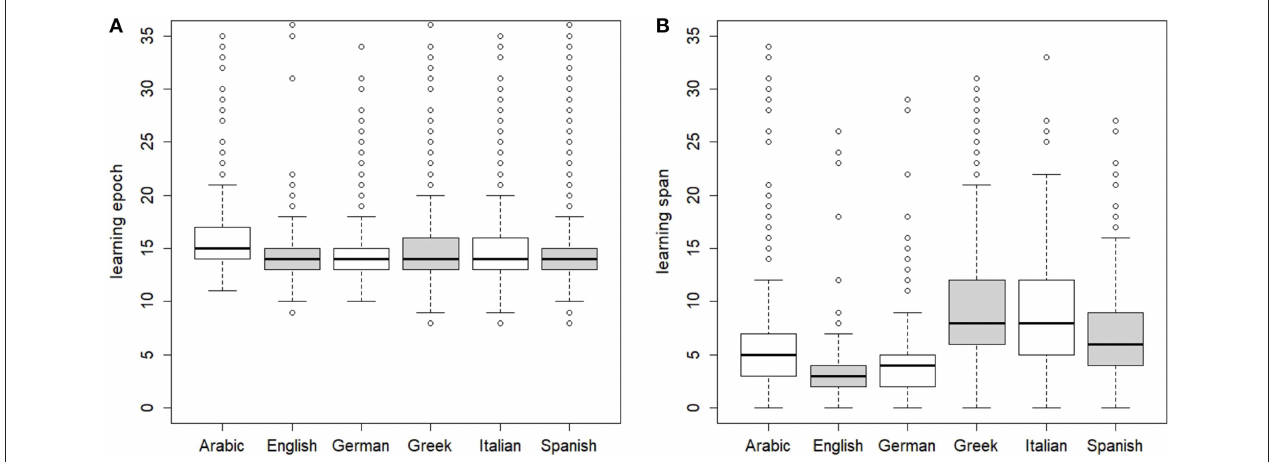
FIGURE 3 | For each language dataset, boxplot distributions of (A) per-word learning epoch and (B) per-paradigm learning